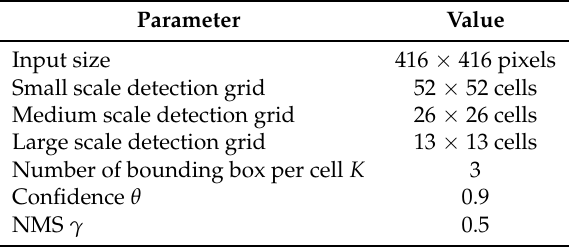
Table 1. YOLO V3 parameters for the detection